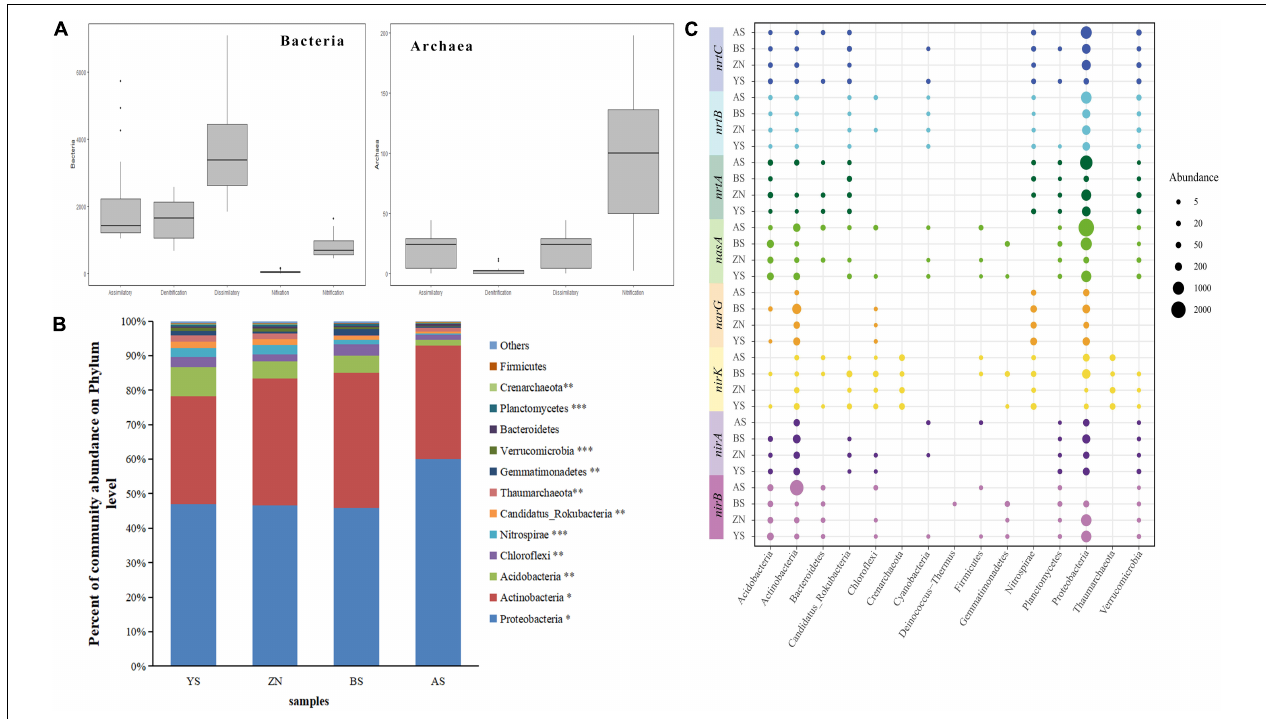
FIGURE 4 | Analysis of nitrogen metabolizing microbial composition in rhizosphere soils. (A) Box plot of the frequency of each N pathway for Bacteria and Archaea. The upper and lower bounds of boxes correspond to the 25th and 75th percentiles, with a median line shown. Whiskers represent 1.5 ∗ IQ R (interquartile range). Dots represent outliers. The abscissa axis represents the nitrogen metabolism pathway name. Assimilatory: assimilatory nitrate reduction, Dissimilatory: dissimilatory nitrate reduction, Nifixation: nitrogen fixation. (B) Nitrogen metabolizing microbial composition at the phylum level. (C) The taxonomic distribution (phylum level) of functional genes. *** p < 0.001, ** p < 0.01 and * p <